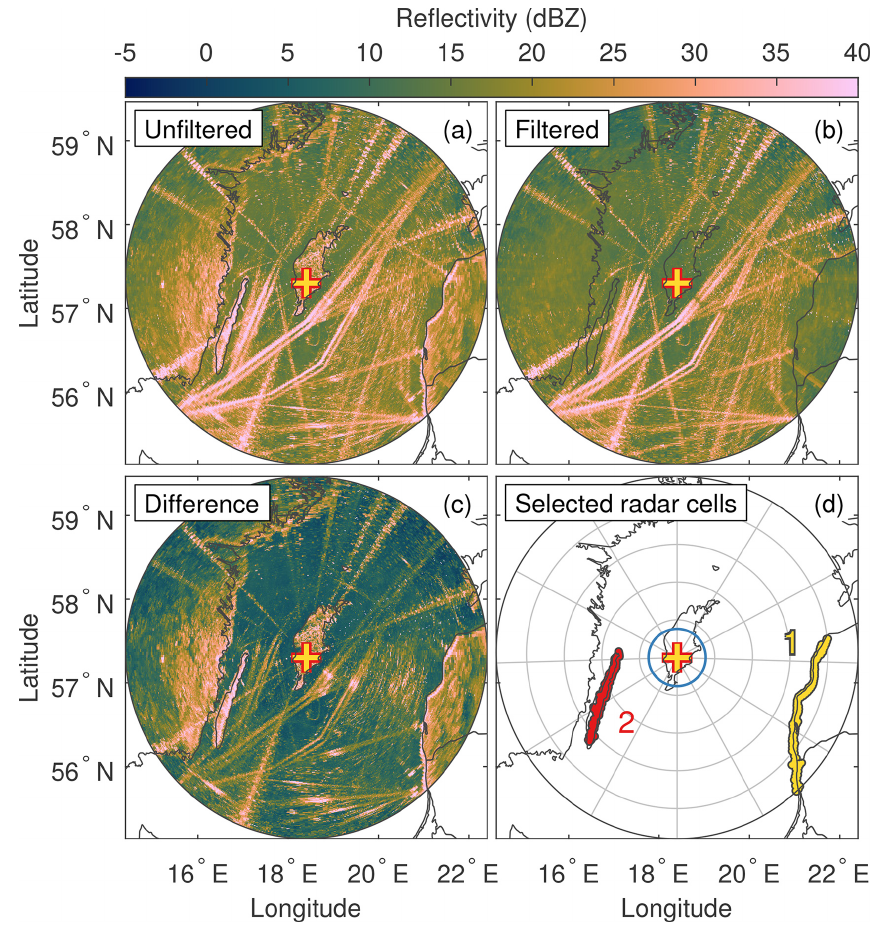
Figure 2. Data from weather radar sehem on the island of Gotland in the Baltic Sea, averaged over June, July, and August 2017–2021. (a) Unfiltered reflectivity data. (b) Doppler-filtered reflectivity data. (c) Difference between unfiltered and filtered reflectivity data. (d) Radar cells from two regions (the island of Öland to the southwest and the coastlines of Latvia and Lithuania to the east) were selected to study the effects of anomalous propagation. The blue ring near the radar shows the radar horizon, assuming standard atmospheric conditions. Range rings are displayed in 50km